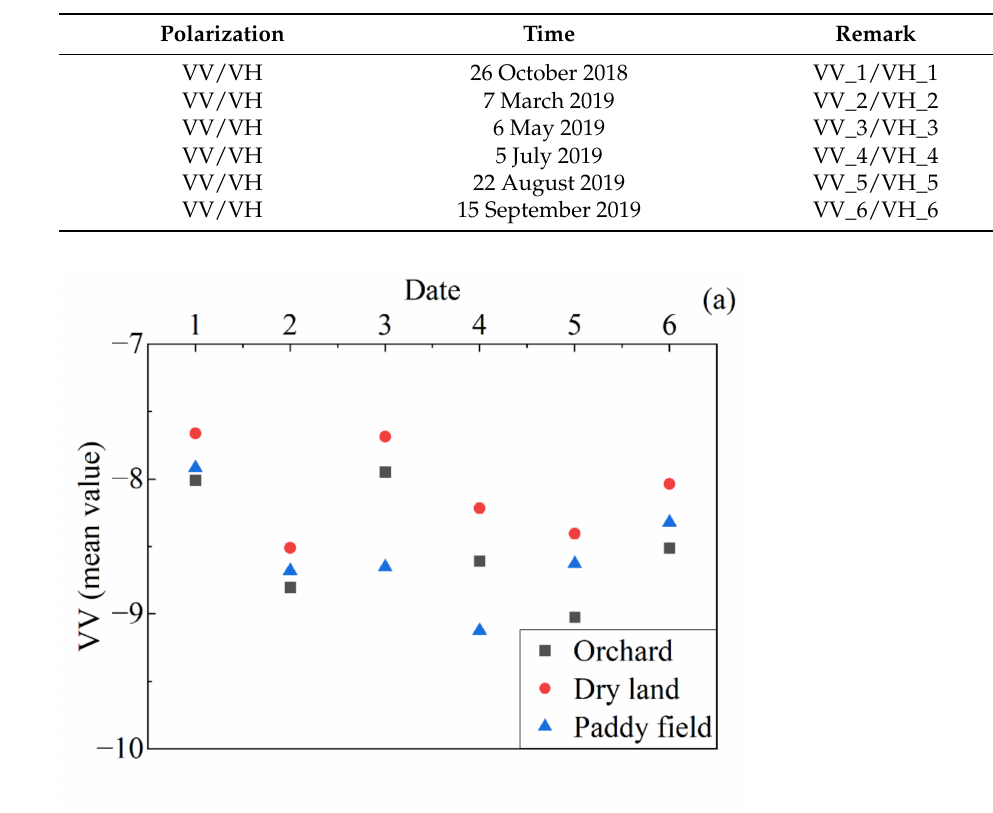
Figure 2. The mean values of VV and VH differ with time and land use type, indicating that multitemporal Sentinel-1 data may be helpful for SOC prediction [38]. Table 1. Sentinel-1 data set.